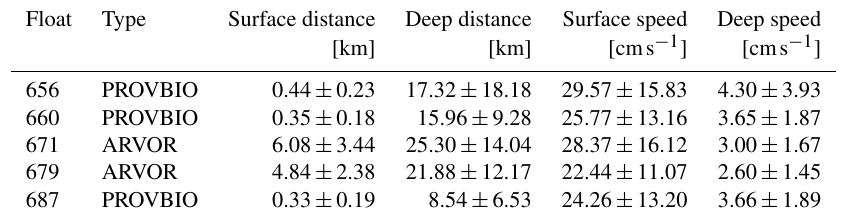
Table 1. Statistics for the different floats between surface and deep trajectories; the results are presented as “mean ± SD”.